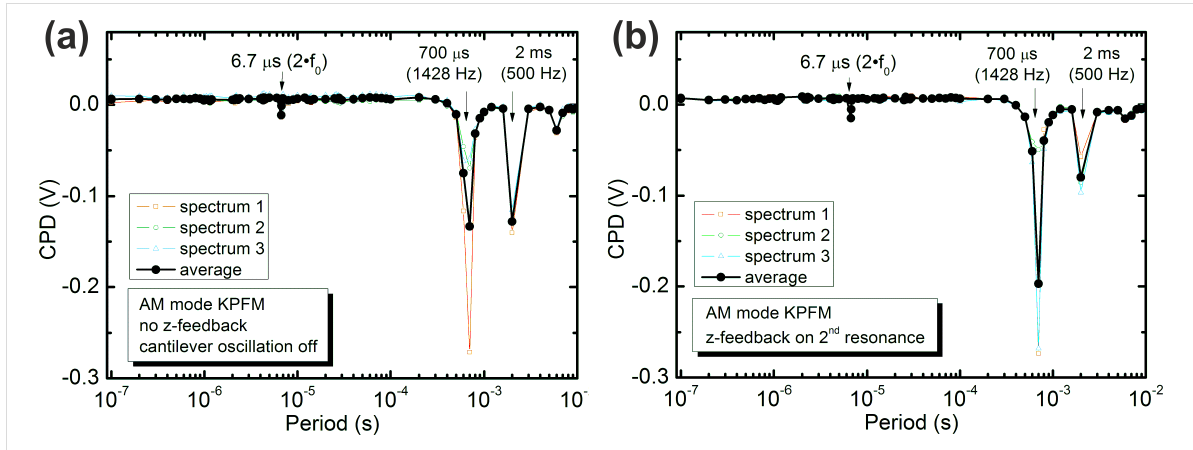
Figure 4: Experimental frequency spectra with a square shaped bias pulse ( V pulse = 0.2 V) of 50% duty cycle. (a) Spectrum taken with the z feed- back and the cantilever oscillation switched off and (b) with the cantilever mechanical oscillation at the 2nd resonance mode ( f 2 = 465.207 kHz) and z feedback switched on. In both cases the Kelvin detection ac bias ( V ac = 0.2 V) is applied at the fundamental resonance frequency ( f 0 = 73.680 kHz).